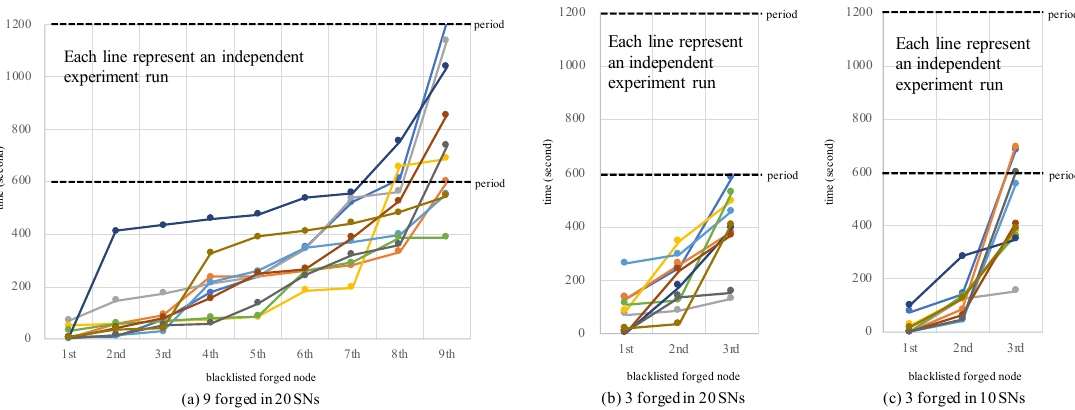
Figure 8. Completion time of blacklisting (mutual verification process) with varying number of forged nodes—results from 10 independent experiment